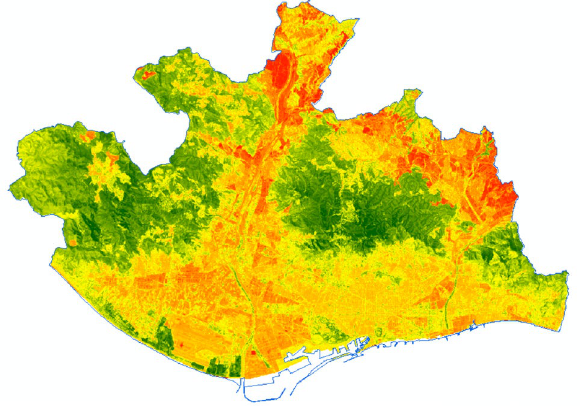
Figure 9. Daytime LST (hybrid model)